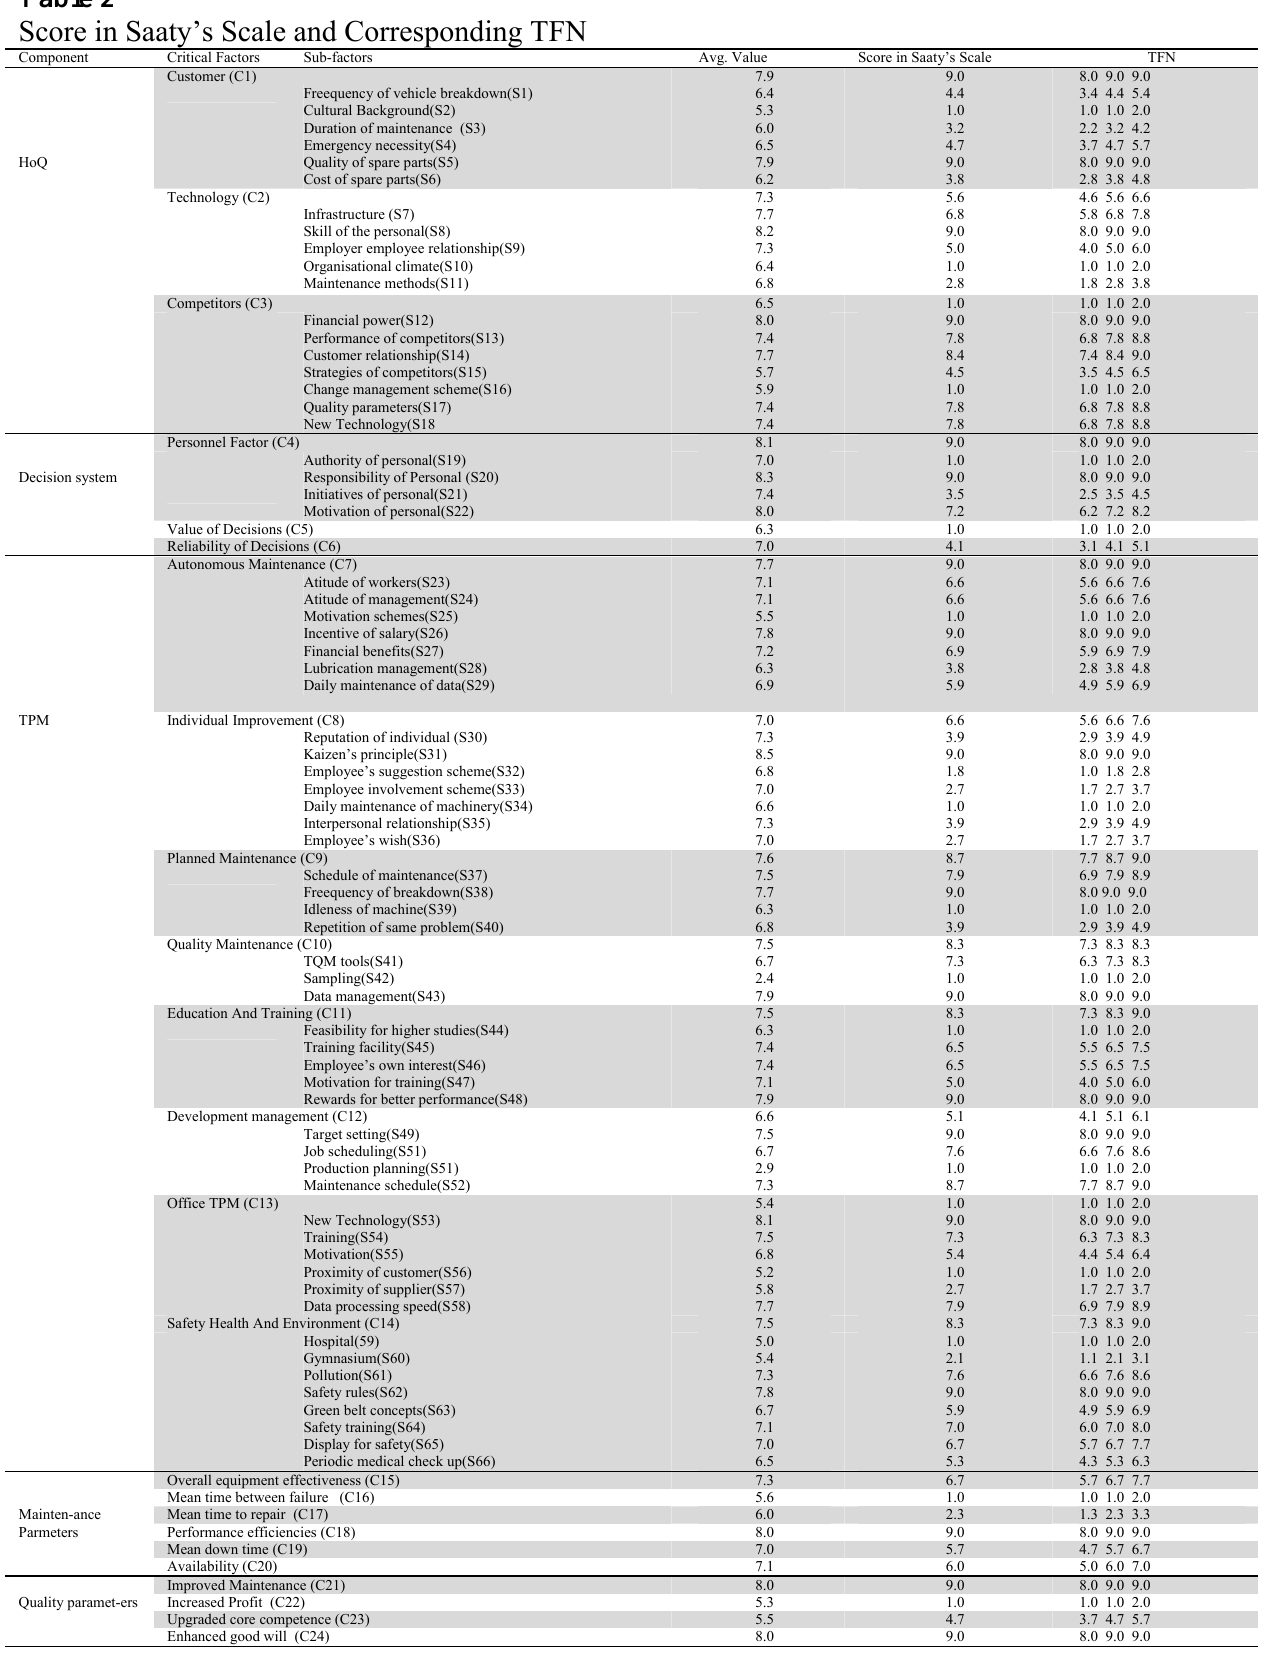
Score in Saaty’s Scale and Corresponding TFN